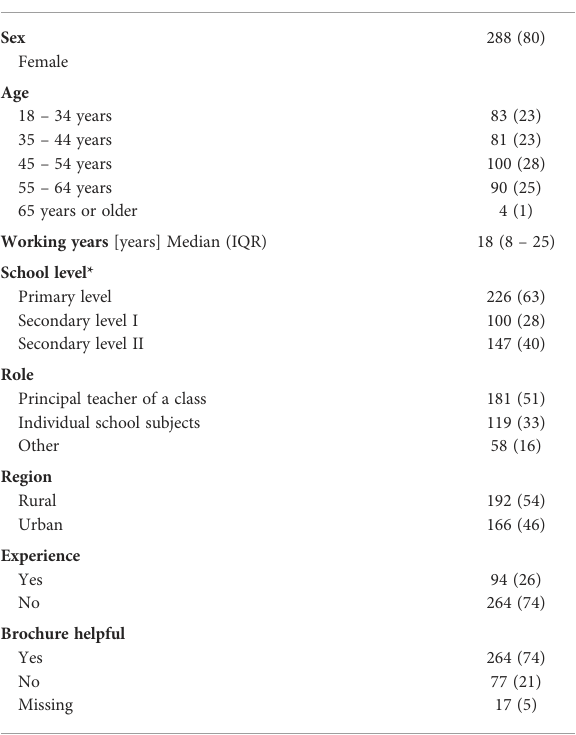
TABLE 1 Characteristics of participating teachers